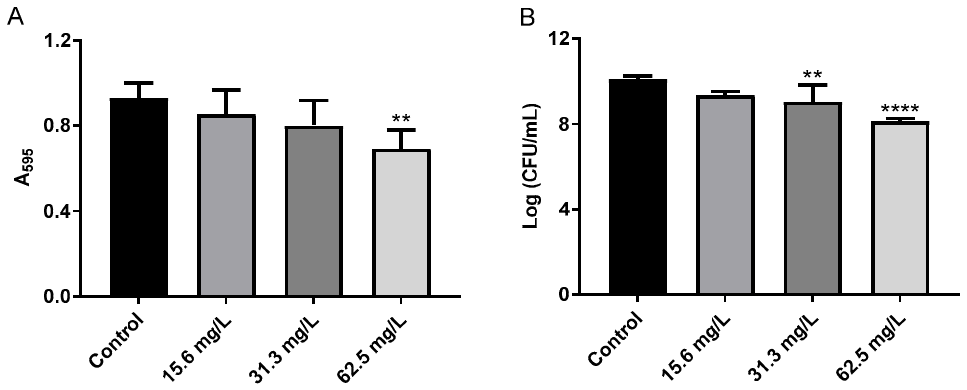
Figure 5. GRA disrupts bacterial cell-surface interactions. ( A ) Bacteria were cultured for 24 h in 24-well plates prior to treatment with 0, 15.6, 31.3, or 62.5 mg/L GRA. The extent of crystal violet staining was evaluated by measuring absorbance at 595 nm and was found to be significantly lower at 62.5 mg/L compared to control. This correlated with a loss in viable bacteria from the surface ( B ), indicating that GRA may enhance biofilm dispersal. The data shown in Figure 5 are the results from at least four experiments per treatment group. Significance was established based on one-way ANOVA (** p ≤ 0.01, **** p ≤ 0.0001).